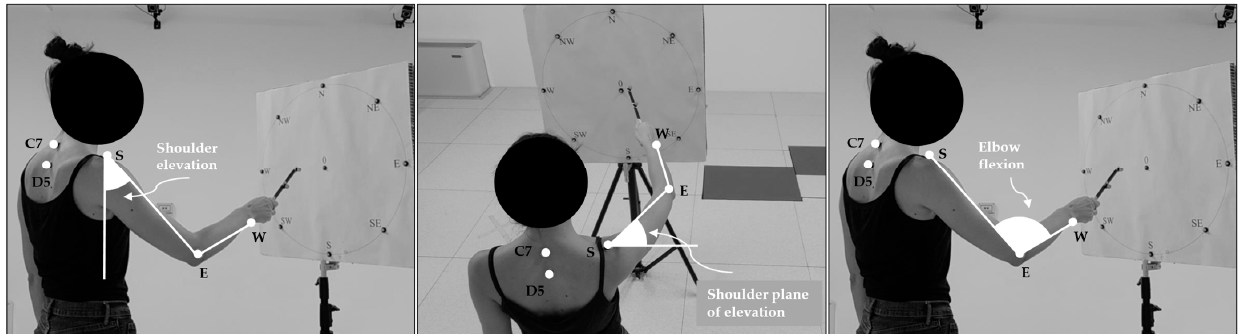
Figure 2. Marker positioning and articular angles. Markers were placed on D5 and C7 vertebras, acromion (shoulder—S), right elbow epicondyle (elbow—E), and on the styloid process of the ulna (wrist—W). Shoulder elevation angle is shown in the first panel, shoulder plane of elevation in the second one and the elbow flexion angle in the last panel.